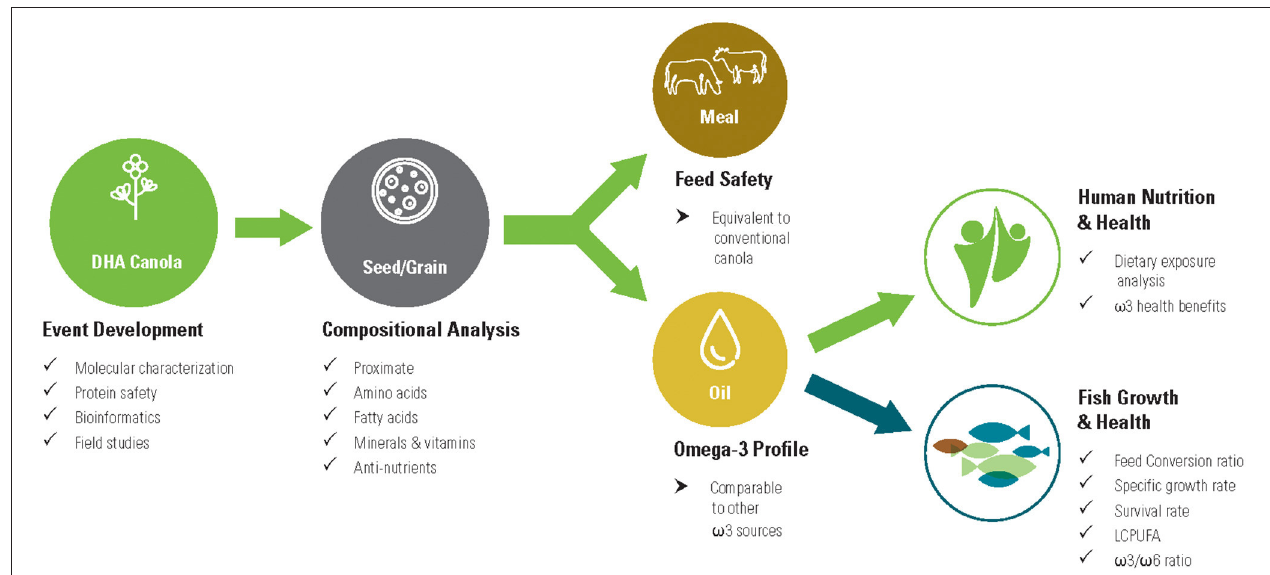
FIGURE 2 | Key studies and safety evaluations of DHA canola for food and feed